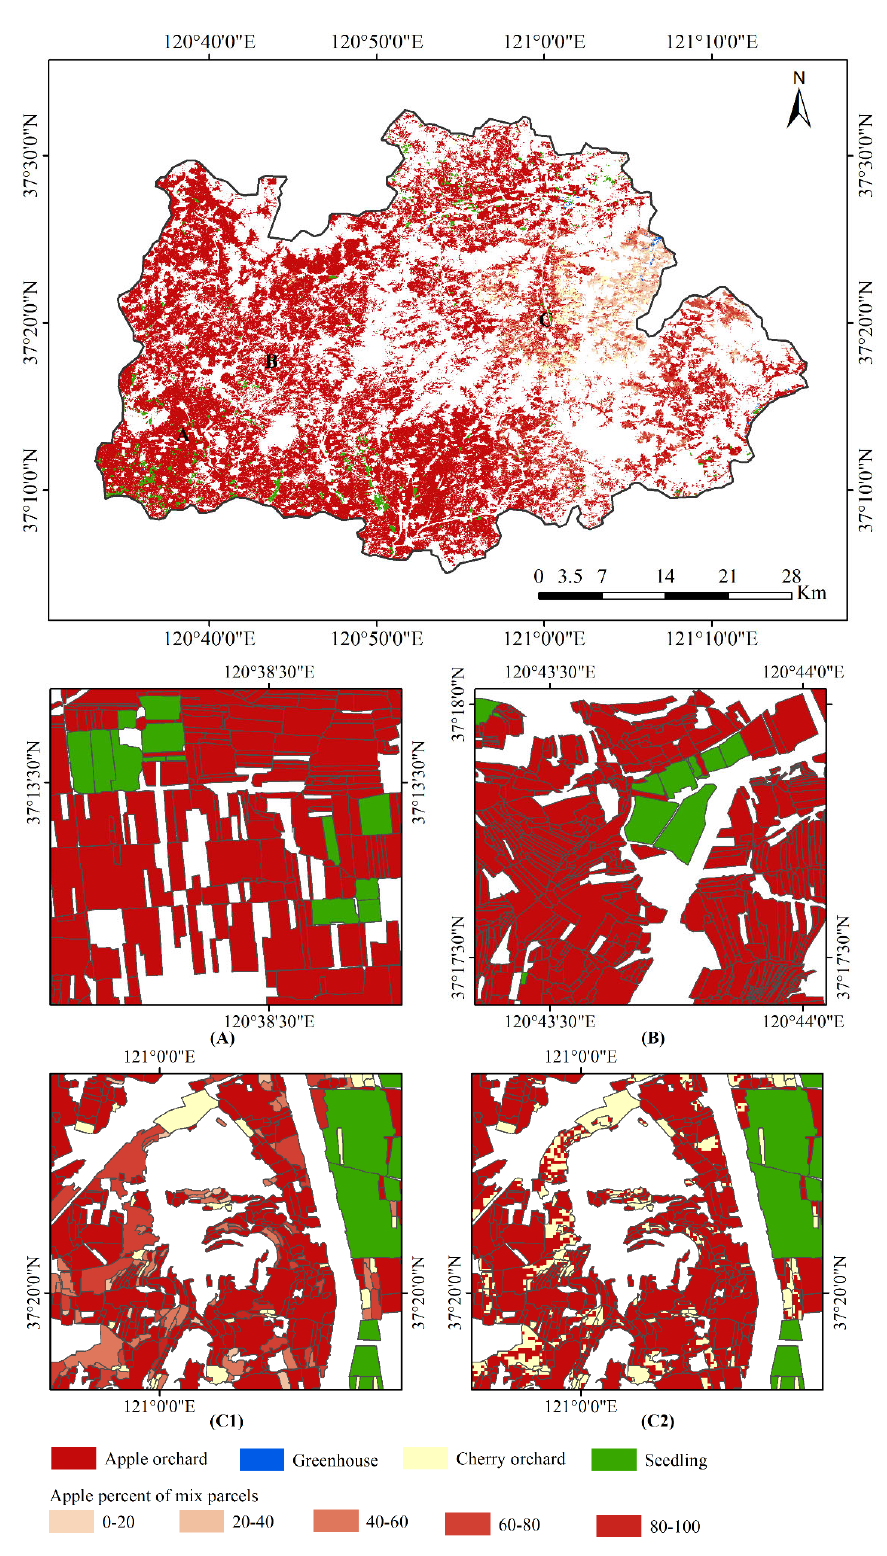
Figure 13. Parcel category filling results. ( A )–( C ) are sub ‐ regions of the study area.